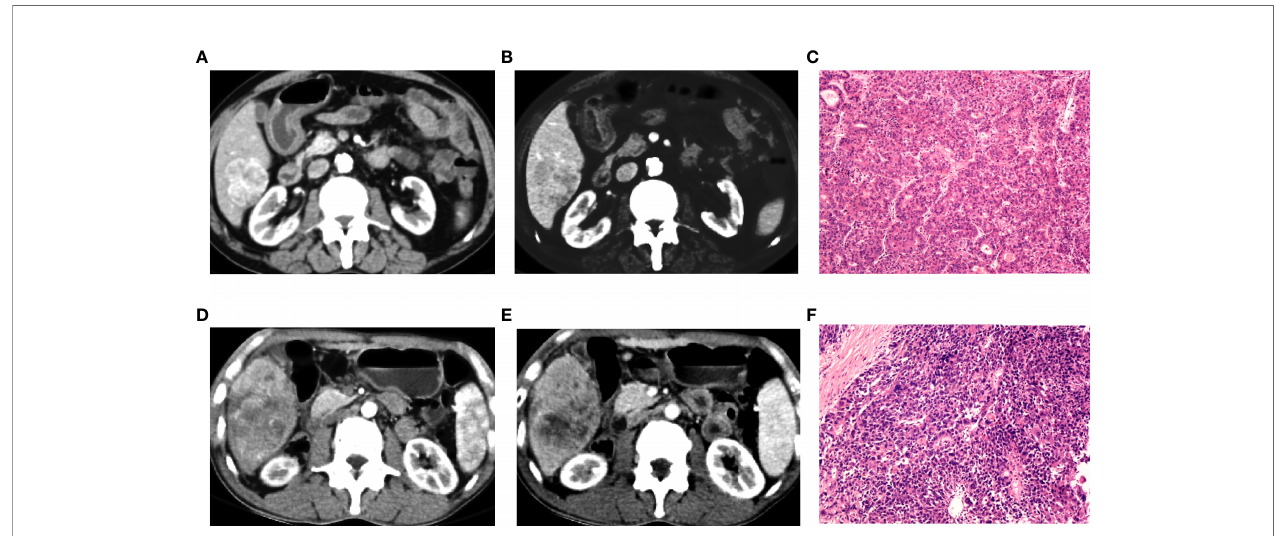
FIGURE 9 | Preoperative contra-enhanced CT images and pathological pictures of two cases with hepatocellular carcinoma (HCC). (A – C) A 72-year-old man with non-early recurrence of HCC, the nomogram judged as low risk. (D – F) A 54-year-old man with early recurrence of HCC, the nomogram judged as high